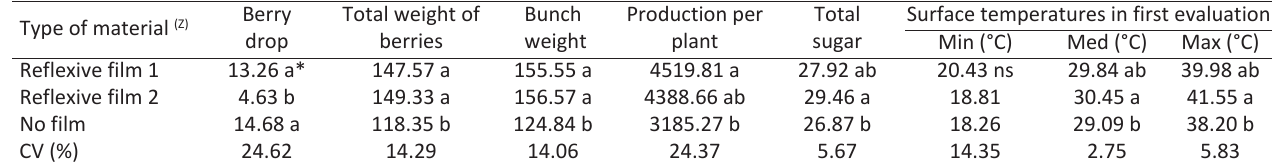
Table 3 - Berry drop (%), total weight of bunches and berries (g), production per plant (Kg) and total sugar (mg/g), minimal, medium and maximum surface temperatures during the first evaluation, of Merlot vines submitted or not to management practices with the use or not of reflexive films on the soil, in productive cycle 1 (2009/2010)